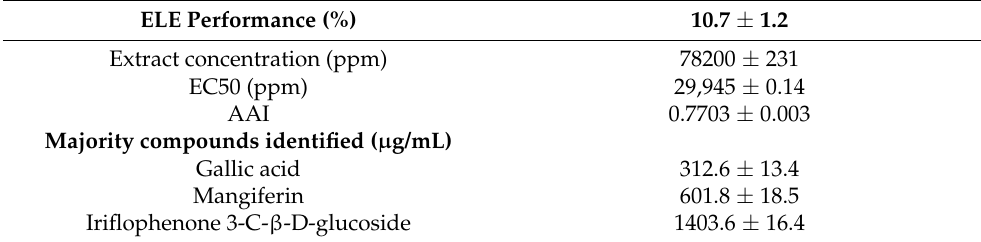
Table 3. Chemical and functional characterization of the